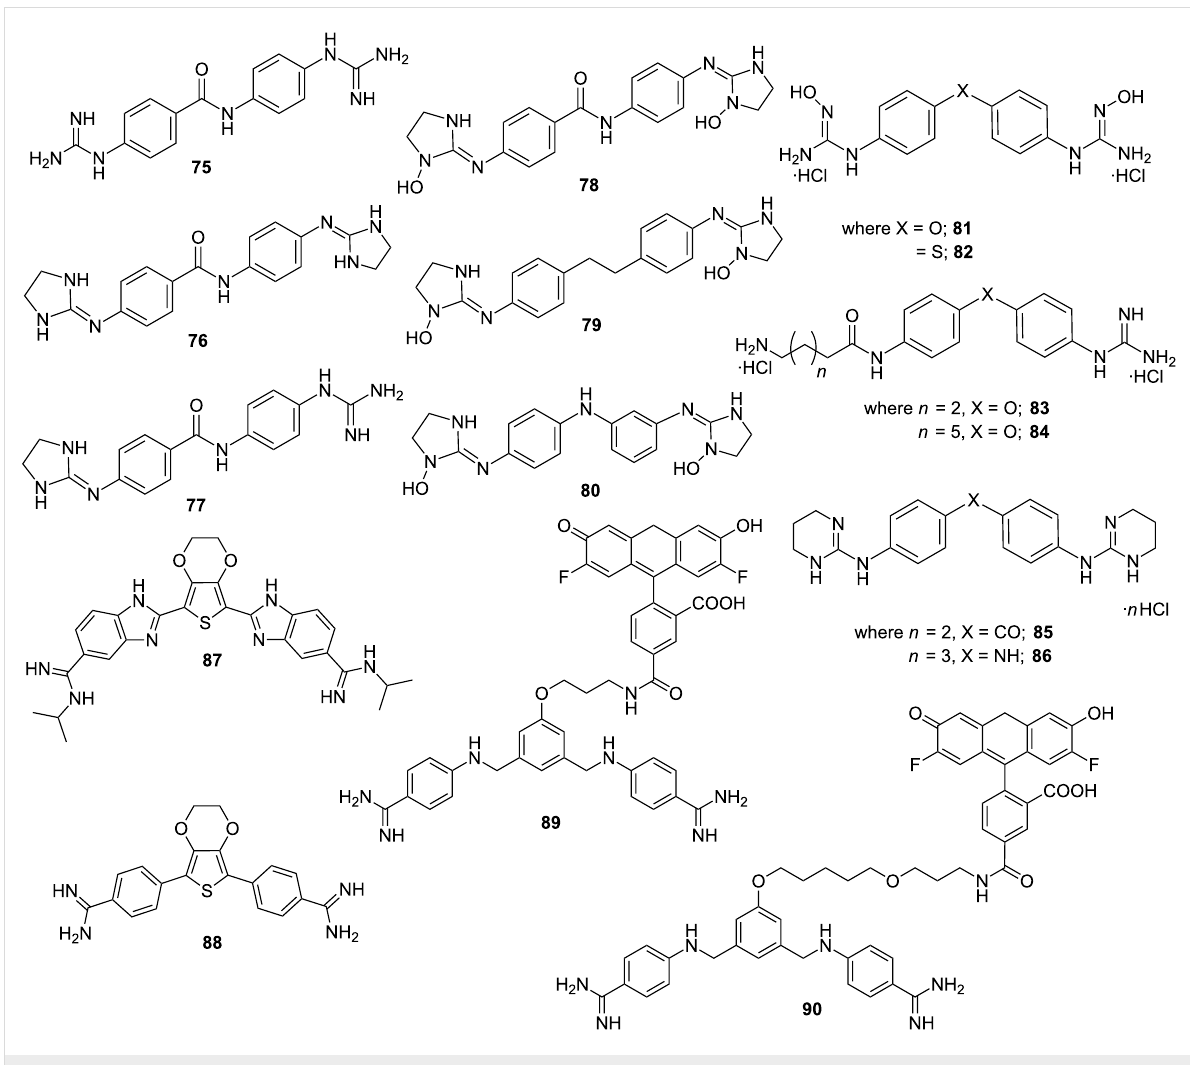
Figure 12: Representative examples of recently developed bisamidine